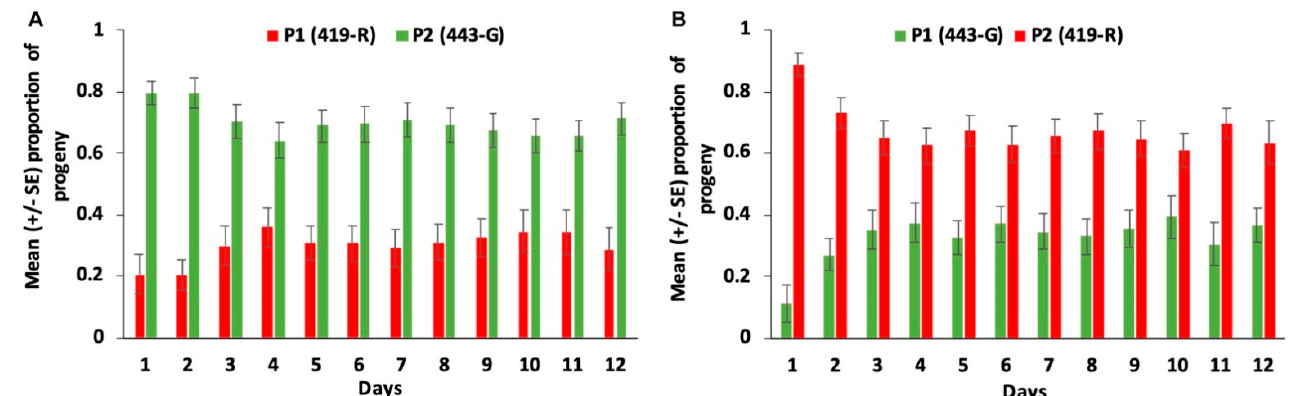
Figure 3. Mean (± std error) green or red fluorescent progeny produced over a 12-day period by A. ludens females mating either first with ( A ) 419-R male (first male P1 red bar), and a 443-G male (second male P2 green bar); or ( B ) a 443-G male (first male P1 green bar) and a 419-R (second male P2 red bar). Each bar represents progeny attributed to each